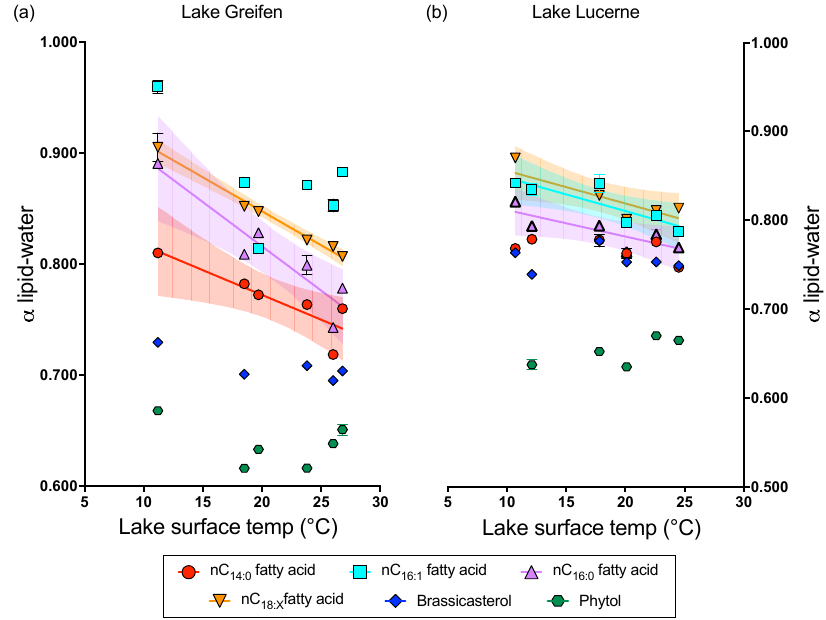
Figure 3. Relationships between α lipid-water values and lake surface temperatures in lakes Greifen (panel a ) and Lucerne (panel b ) throughout the spring and summer of 2015. Error bars are propagated 1 σ uncertainty from replicate measurements of surface water and lipid δ 2 H val- ues. In cases where error bars are not visible, they are smaller than the marker size. Shading represents 95% confidence intervals of the linear regression. Statistics associated with each curve are summarized in Table 2, and plots of individual compounds are available in the